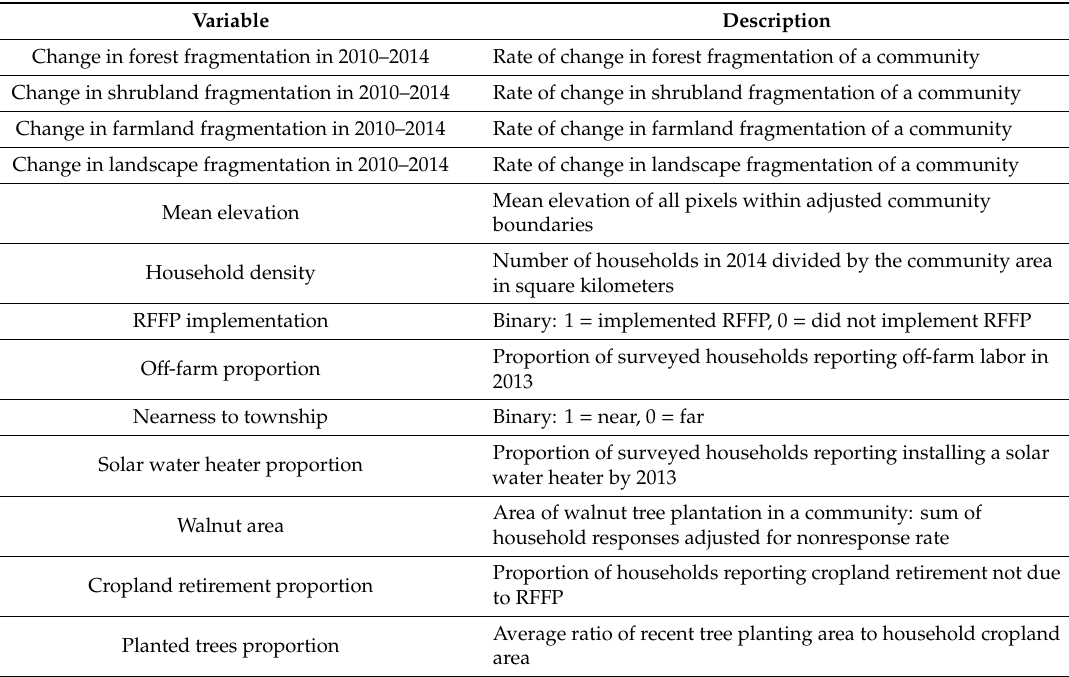
Table 4. Variable